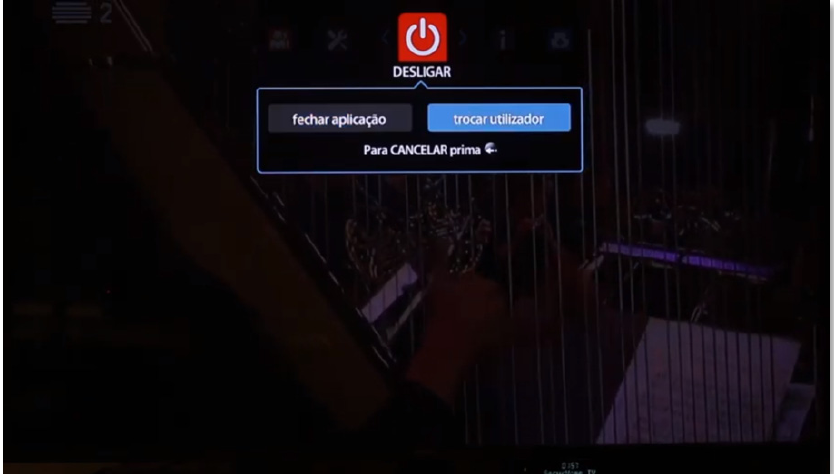
Figure 11. Turning off SecurHome TV.